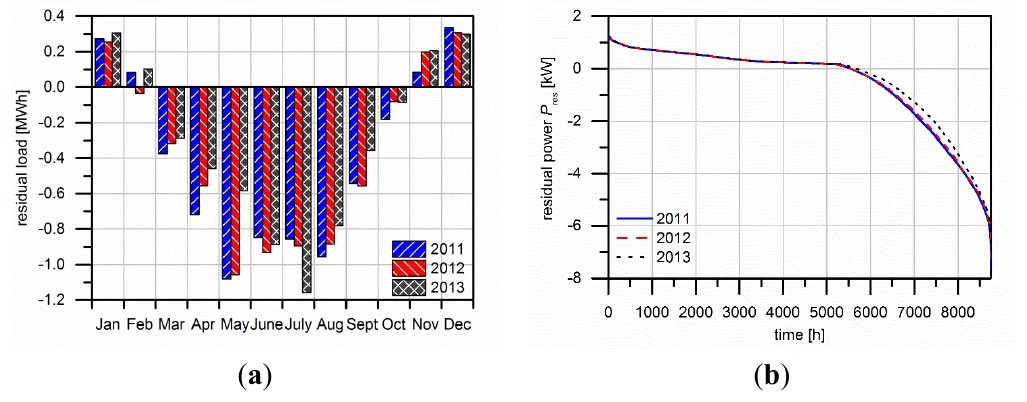
Figure 3. ( a ) Annual distribution of residual load; ( b ) Annual duration curve of residual power.